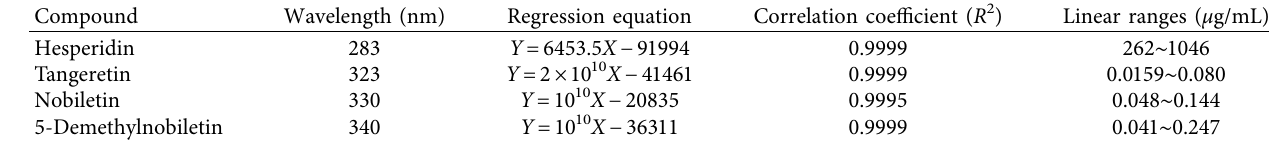
Table 2: UPLC calibration curve data for reference standards.